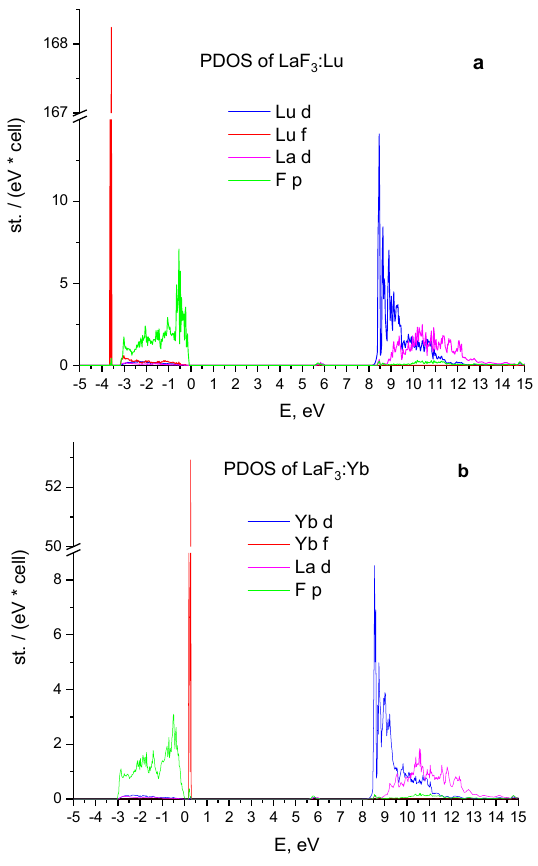
Figure 2. Partial density of states of the LaF 3 :Lu ( a ) and LaF 3 :Yb ( b) crystals.